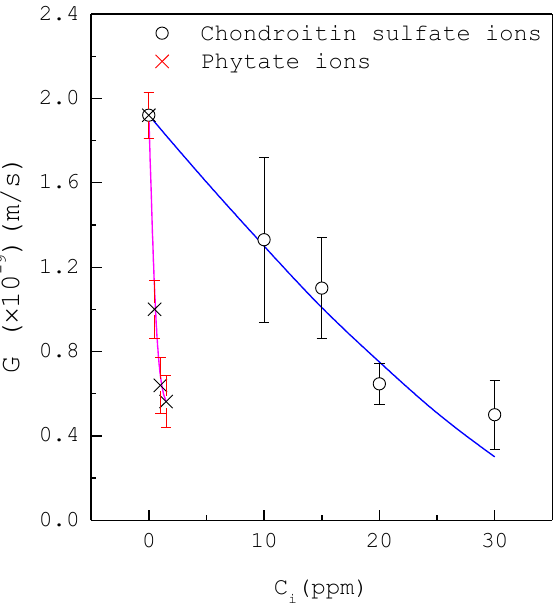
Figure 6. The decrease of the growth rate with increasing inhibitor concentration of chondroitin sulfate ions or phytate ions for S = 13.65 at 37 ◦ C. Each point represents the mean growth rate for eight crystals and the error bar represents the 95% confidence interval for the growth rate. Lines are visual